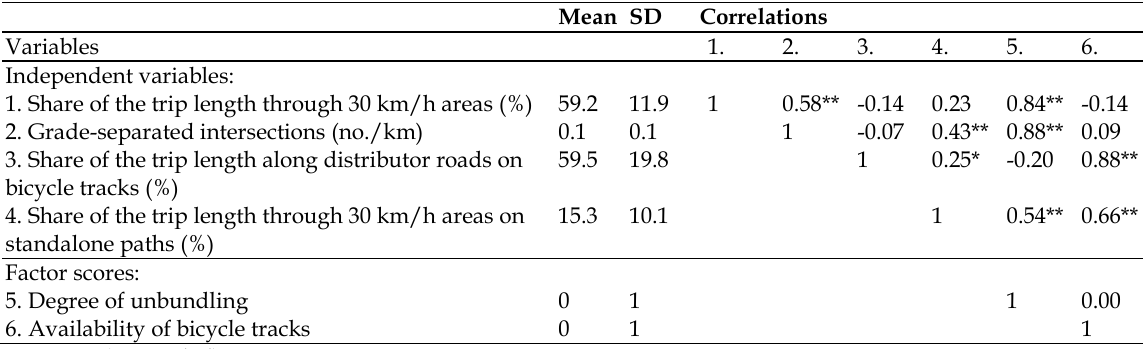
Mean SD Correlations